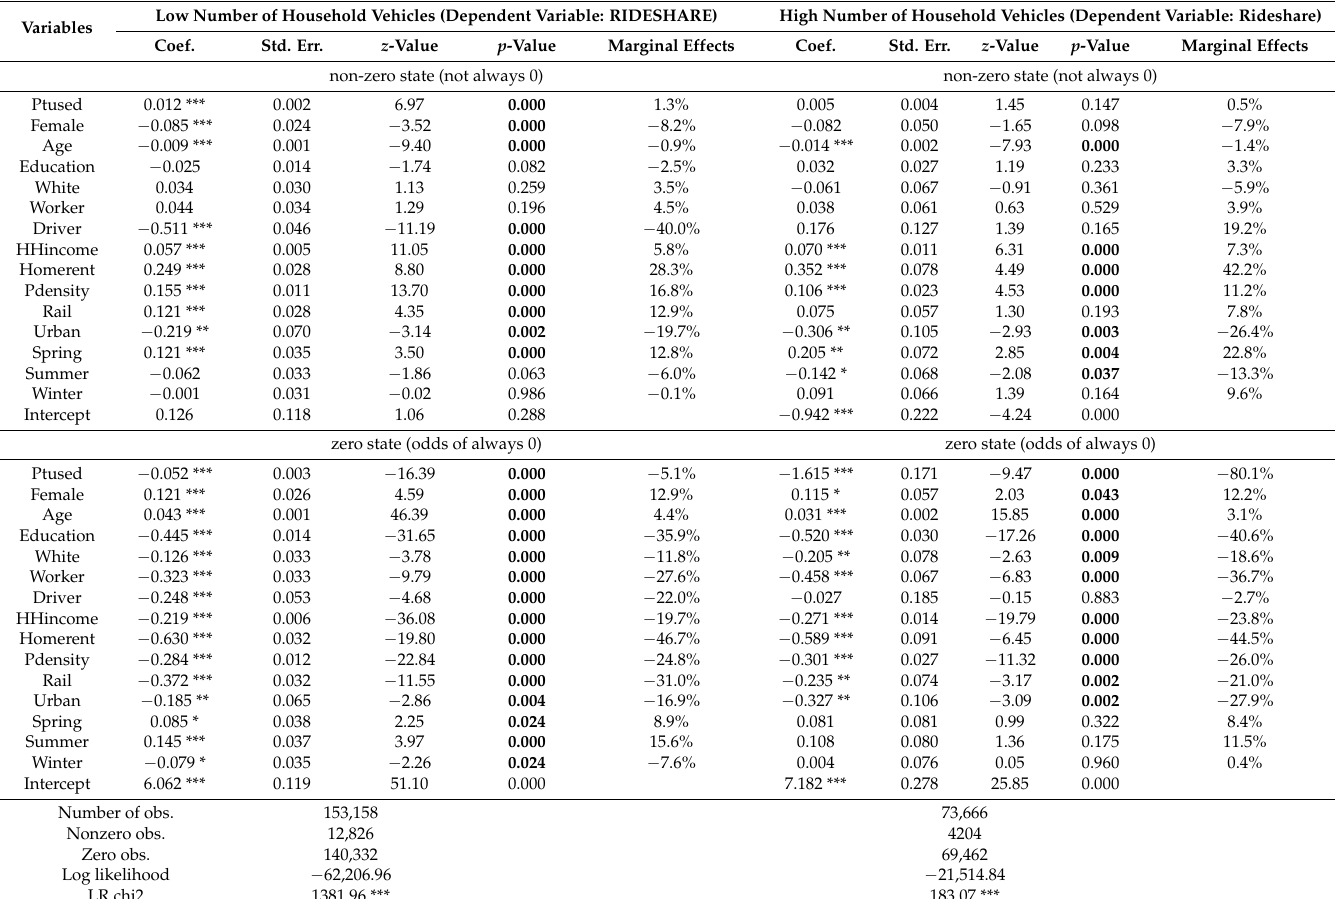
Table 4. Results for the relationship between ridesharing and public transit use varying by the household vehicle ownership. Low Number of Household Vehicles (Dependent Variable: RIDESHARE) High Number of Household Vehicles (Dependent Variable: Rideshare) Variables